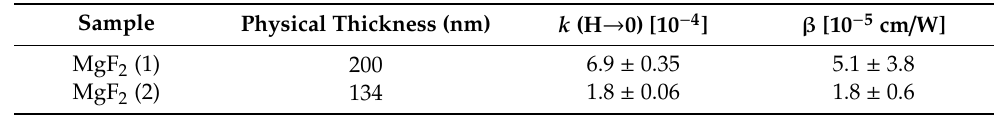
Table 1. Linear absorption k and two-photon absorption coe ffi cient β of the investigated MgF 2 single layers.